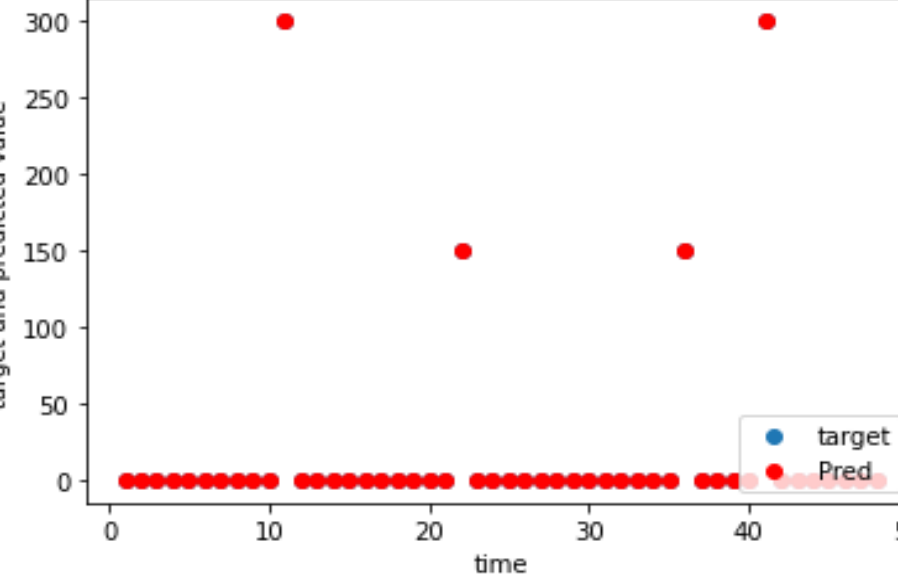
Figure 8. Charging demand prediction of a weekend for Teekkarikylä.